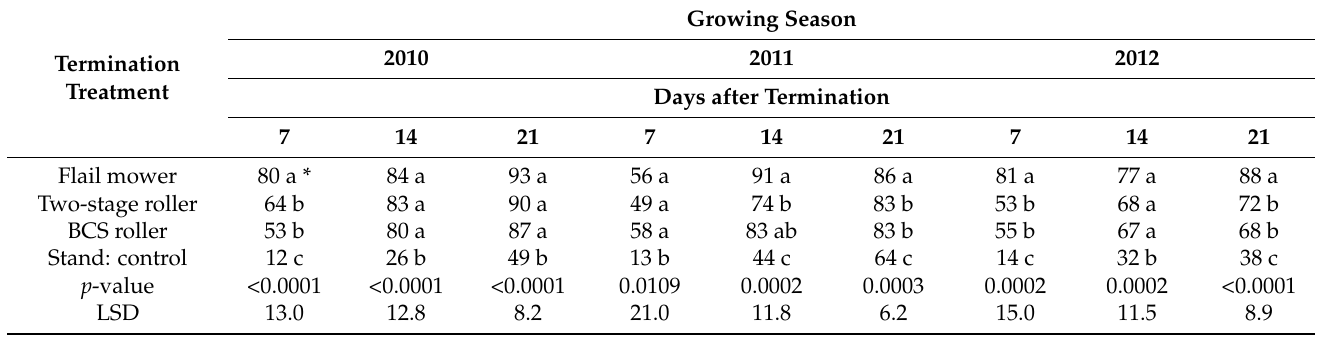
Table 6. Termination rates (%) for crimson clover during three weeks of evaluation in three growing seasons